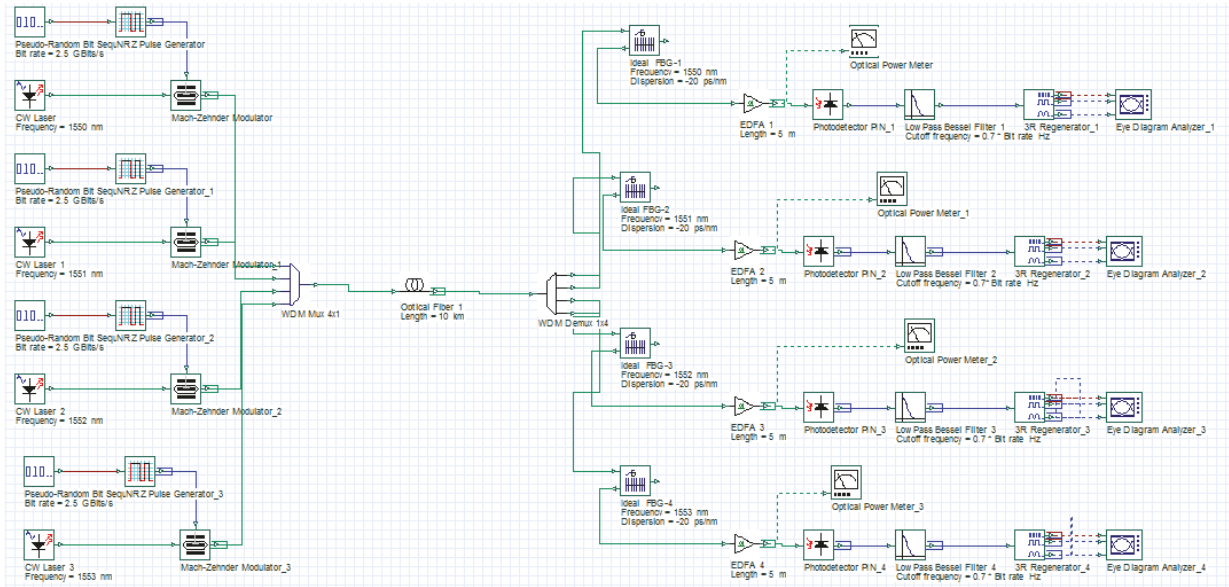
Figure 9: Proposed model of four channels WDM transmission system.